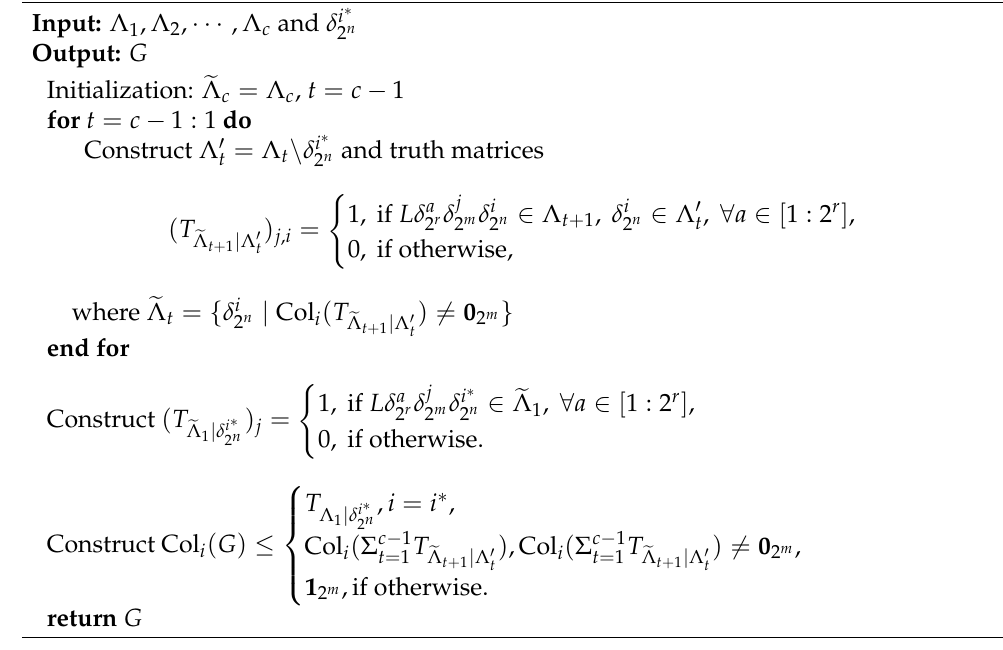
Algorithm 1 Design of controller for tracking a reference output